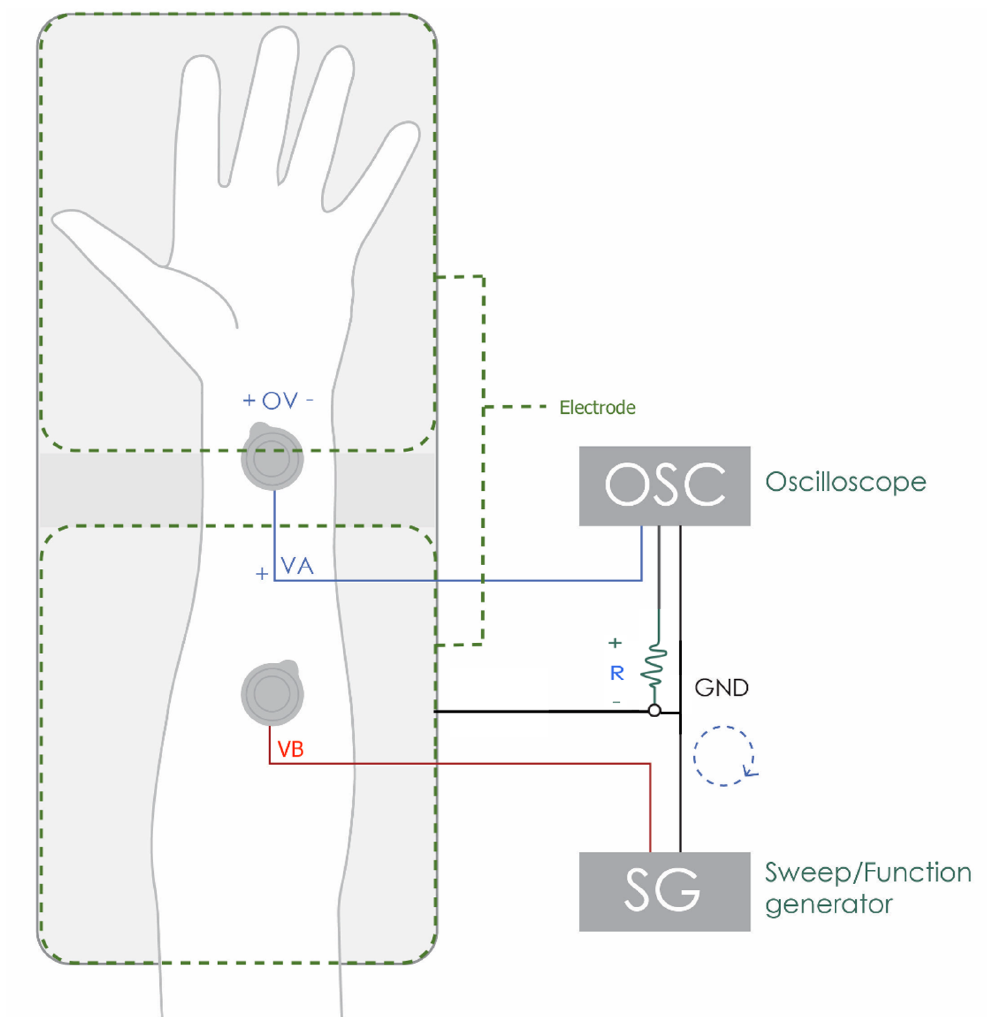
Figure 3. Experimental setup for skin-to-electrode impedance measurement. Table 1. Impedance between skin and